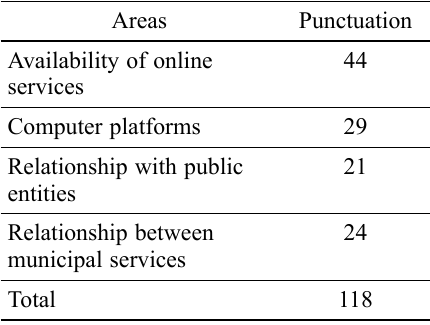
Table 15. Areas in which the